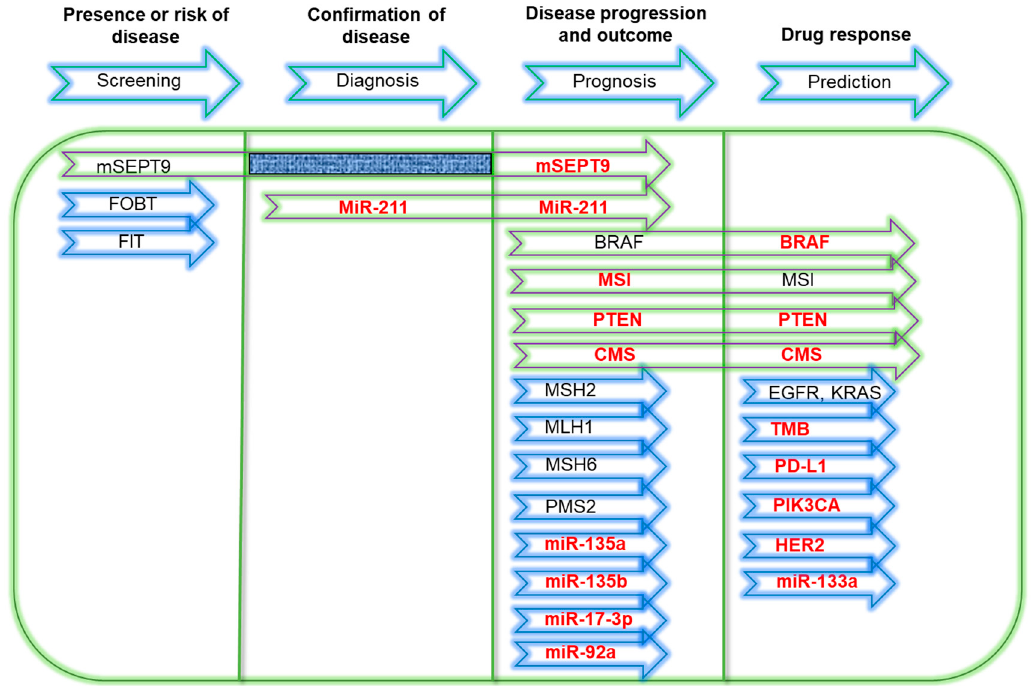
Figure 2. Simplified summary of CRC biomarkers. Green arrows represent biomarkers that have more than one role. Biomarkers colored in red are potential CRC biomarkers that require additional validations. BRAF- v-raf murine sarcoma viral oncogene homolog B1; FIT- fecal immunochemical test; CMS- consensus molecular subtypes; EGFR- epidermal growth factor receptor; FOBT- fecal occult blood test; HER2- human epidermal growth factor receptor 2; KRAS- Kirsten rat sarcoma viral oncogene homolog; miR- microRNA; MLH1- human mutL homolog 1; mSEPT9- methylated Septin 9; MSH2- human mutS homolog 2; MSI- Microsatellite instability; PD-L1- Programmed death-ligand 1; PIK3CA- phosphatidylinositol-4,5-bisphosphate 3-kinase, catalytic subunit alpha; PMS2- PMS1 homolog 2, mismatch repair system component; PTEN- Phosphatase and tensin homolog; TMB- tumor mutational burden.